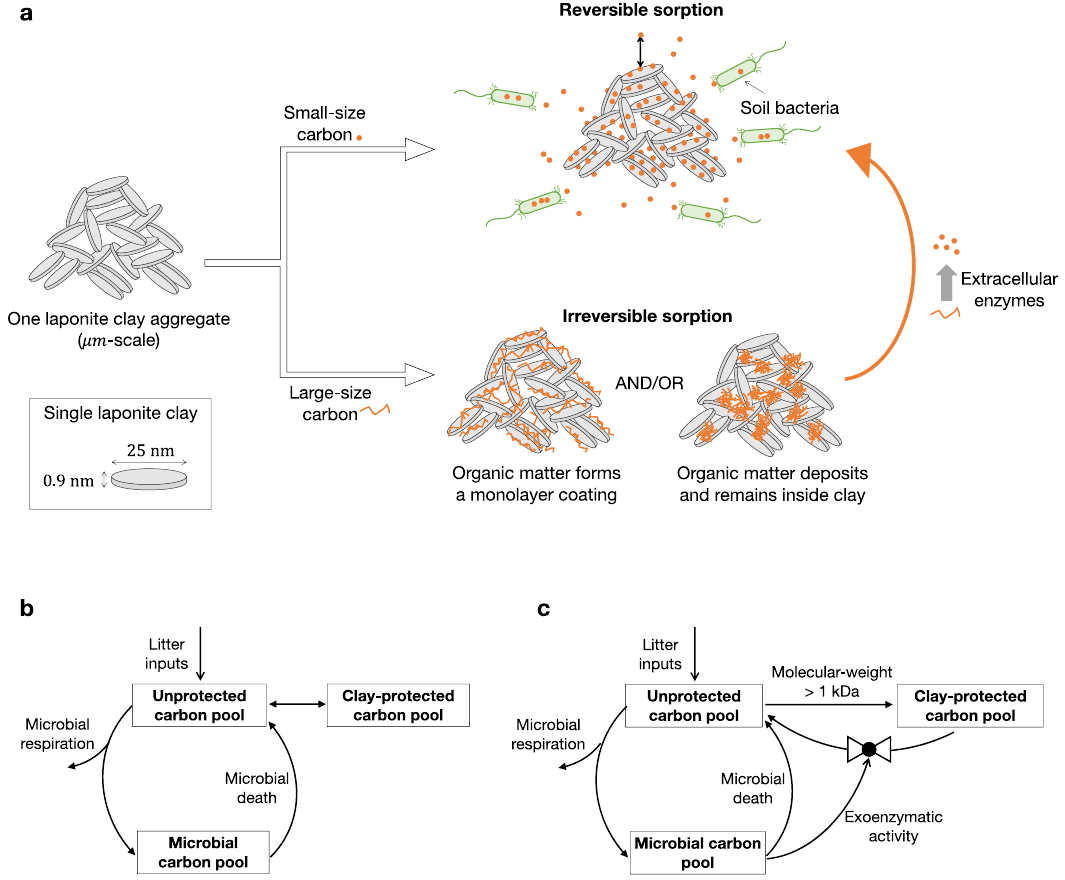
Fig. 4 Proposed conceptual model for soil carbon interaction with clay minerals and implications for soil carbon models. a An integrated conceptual model for interactions between clay, carbon, microbes, and exoenzymes is proposed. Note: drawing not to scale. b A representative soil carbon model structure, which implements clay – carbon protection and biotic activity as distinct processes 5,18 . c A revised soil carbon model that implements clay – carbon protection and biotic activity as coupled processes. The release of the clay-protected carbon could be modeled as a function of exoenzymatic activity, which is likely a function of the bacterial biomass and growth Micron-size clay aggregates were created by mixing the clay powder with a background buffer solution using a vortex mixer at 200rpm for about 1min. The supplemented with micronutrients (0.03 μ M (NH 4 ) 6 (Mo 7 ) 24 , 4 μ M H 3 BO 3 , 0.3 μ M CoCl 2 , 0.1 μ M CuSO 4 , 0.8 μ M MnCl 2 , 0.1 μ M ZnSO 4 , and 0.1 μ M FeSO 4 ). The average pore size of the laponite clay is around 2nm 37 . The measured pH of the solution is 7. The organic matter used in this study is shown in Supplementary Fig. 1 and listed in Supplementary Table 1. The fl uorescent glucose, 2-NBDG (2- (N-(7-Nitrobenz-2-oxa-1,3-diazol-4-yl)Amino)-2-Deoxyglucose), was pur- chased from Thermo Fisher Scienti fi c (Catalog number: N13195). The FITC dextrans were purchased from Sigma (CAS Number 60842-46-8). The enzyme used in this study is dextranase produced by Penicillium sp. (a fungi) and pur- chased from Sigma (CAS Number 9025-70-1). Micro fl uidic clay sorption and desorption experiments . The micro fl uidic channels used in this study, such as the ones shown in Figs. 1 and 3, were fabricated using soft lithography 38 . To fabricate a micro fl uidic channel, we fi rst made a mold for the channel on a SU-8-coated silicon wafer using the laser pattern generator Heidelberg microPG101 (Princeton PRISM Center). Afterwards, we made the channel from the mold by pouring polydimethylsiloxane (PDMS) on the molded